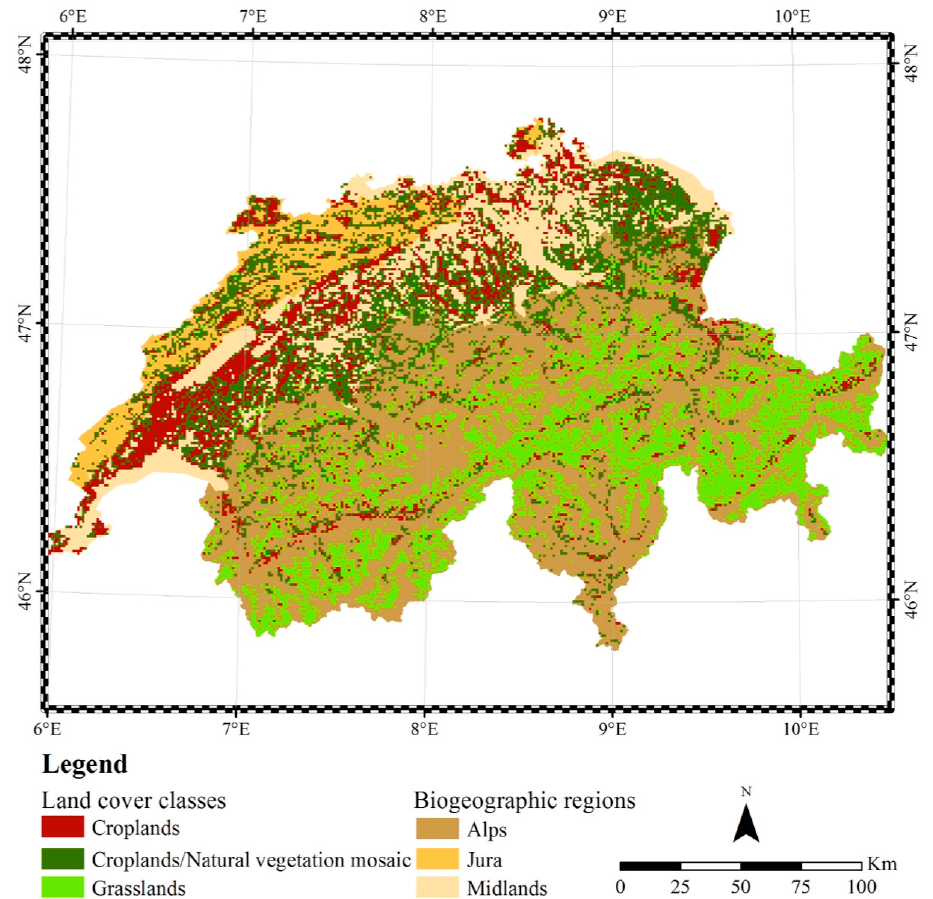
Figure 1. Study area. Land cover classes distributed across (aggregated, e.g., Alps) biogeographic regions. Coordinate system: WGS84.